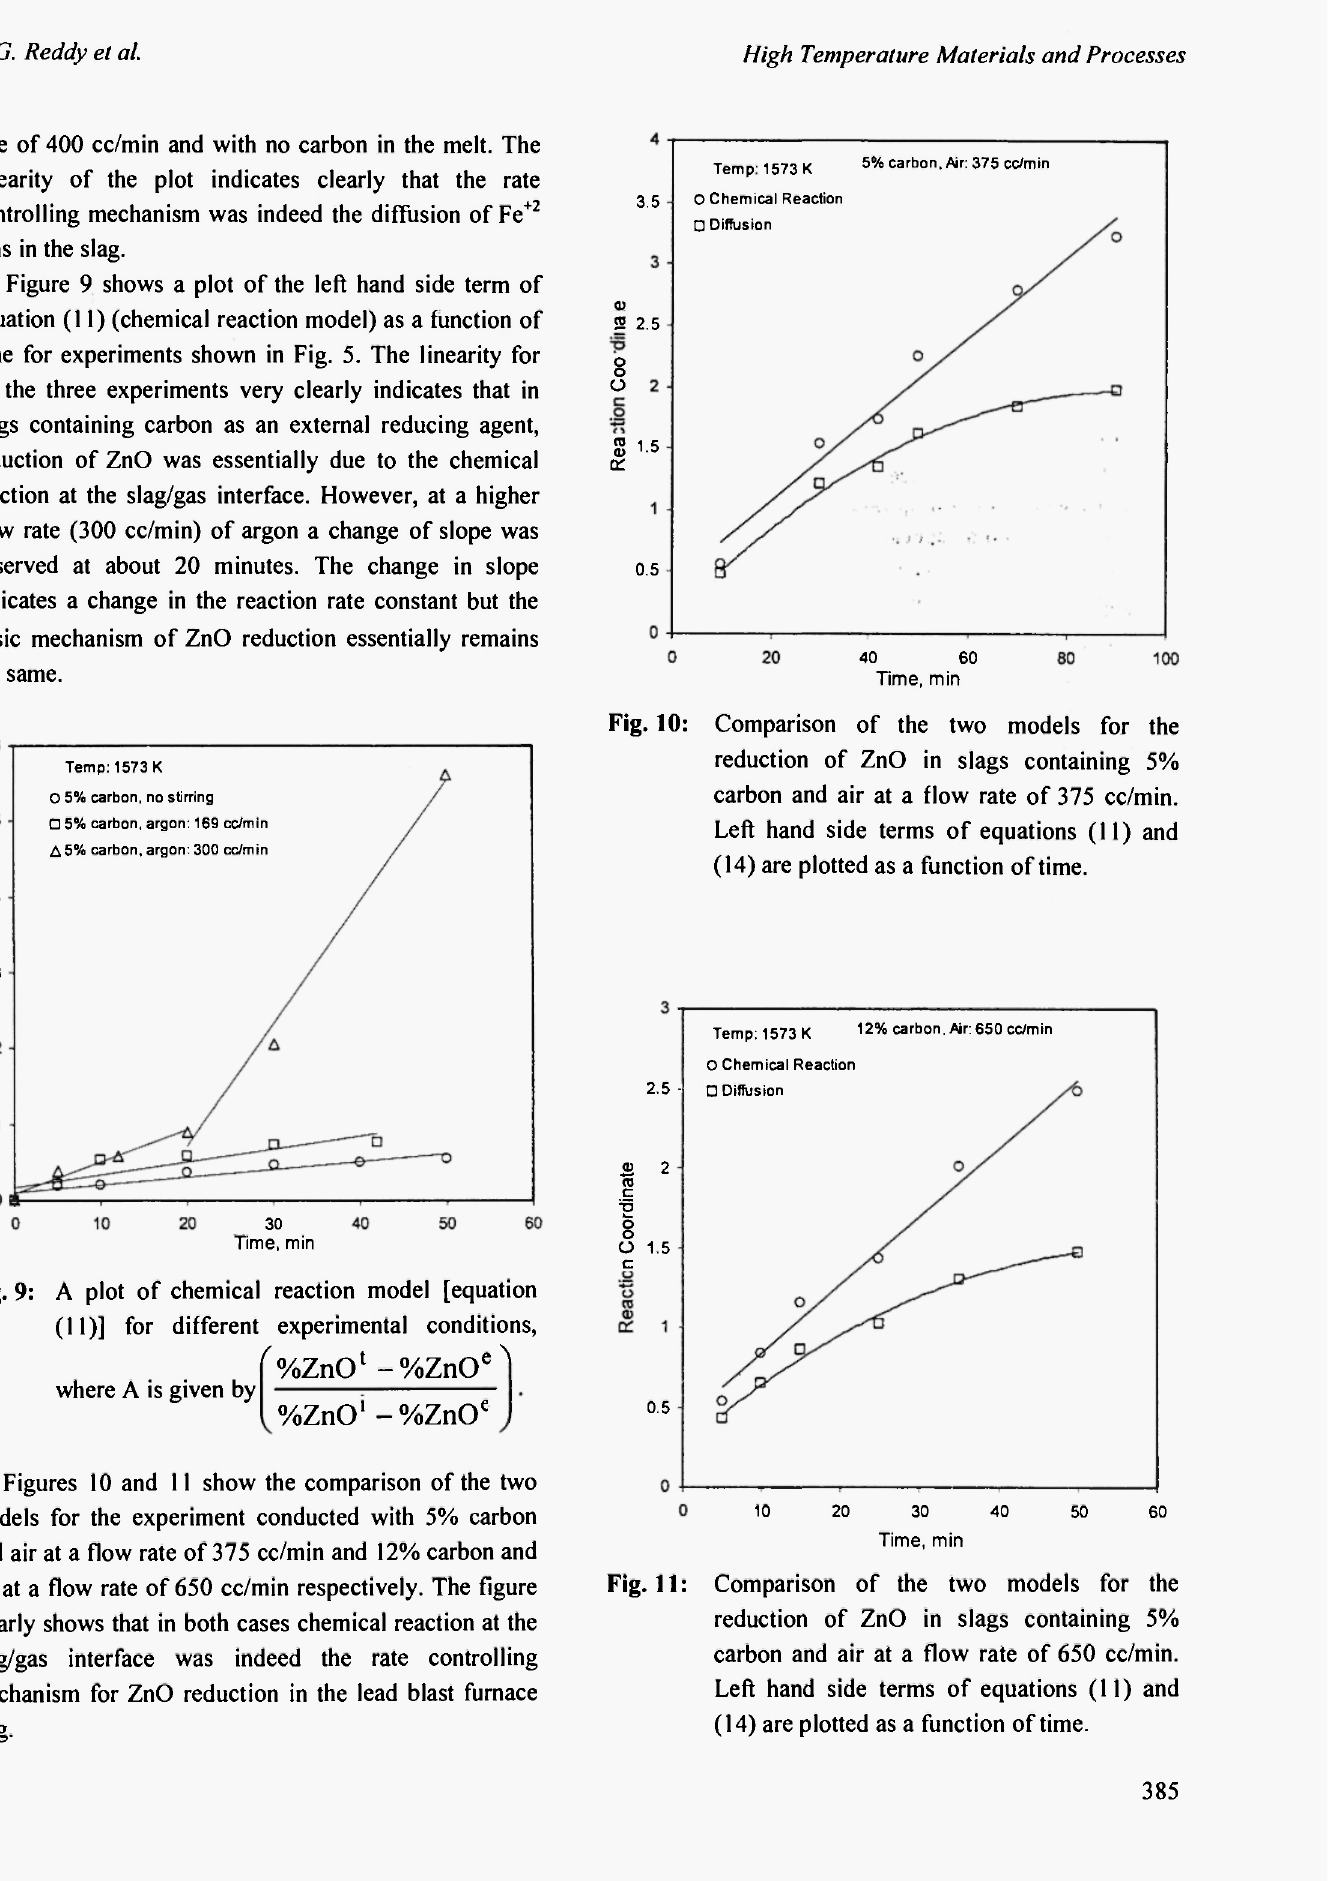
Fig. 11: Comparison of the two models for the reduction of ZnO in slags containing 5% carbon and air at a flow rate of 650 cc/min. Left hand side terms of equations (11) and (14) are plotted as a function of time.